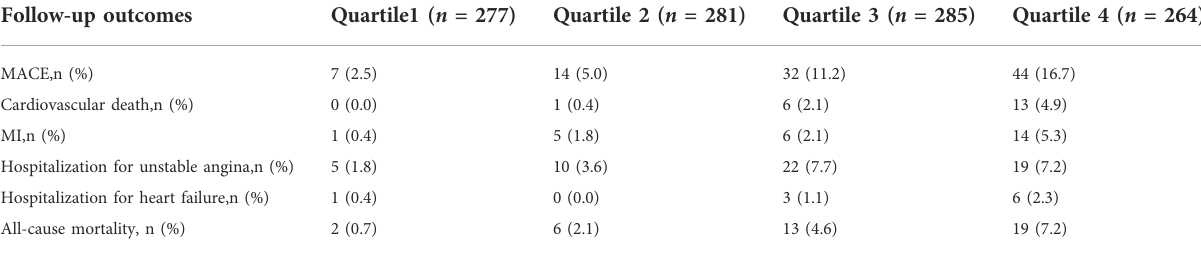
TABLE 3 Crude number of clinical outcomes during